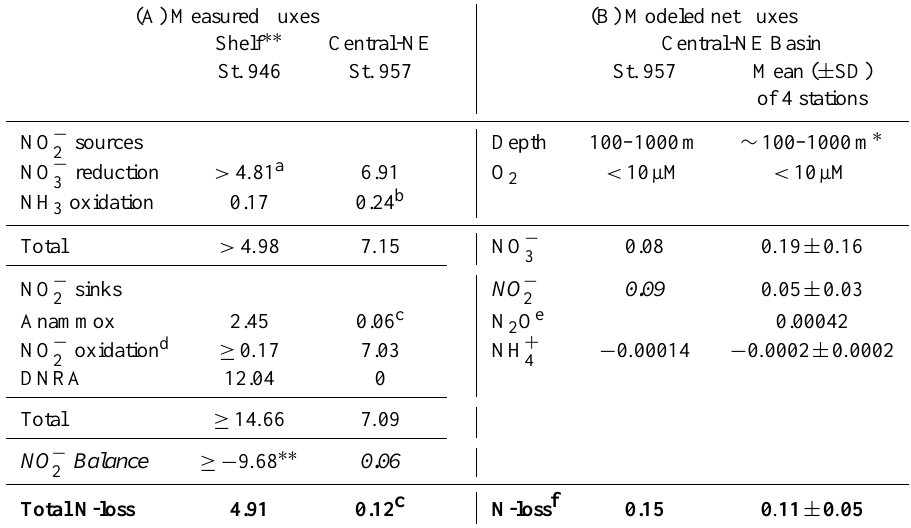
, NO − , NO − , N 2 O and 4 2 3 balance in the 2